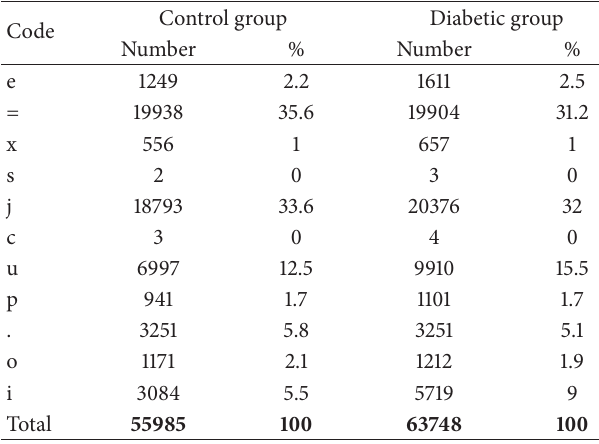
Table 1: Transcripts assembled with Cufflinks and percentage from both the control and diabetic groups.